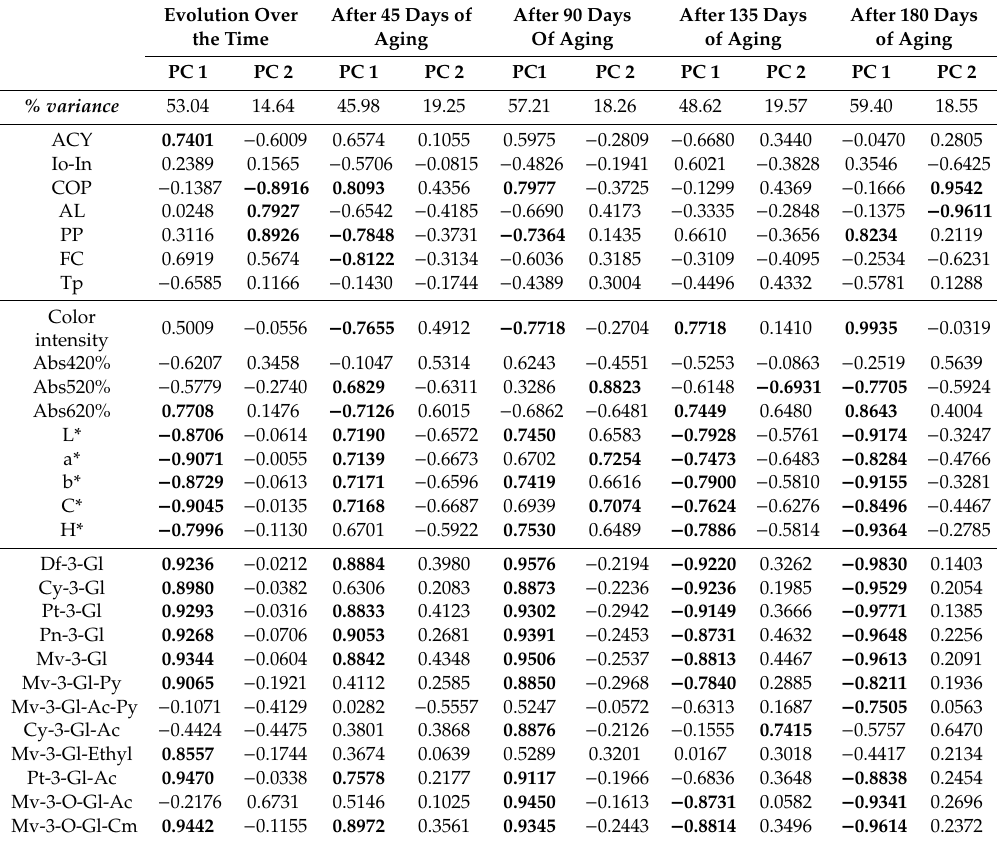
Table 4. Principal component analysis (PCA) results carried out with copigmentation, color parameters and individual anthocyanins in wines aged with di ff erent aging systems after di ff erent aging times (45, 90, 135 and 180